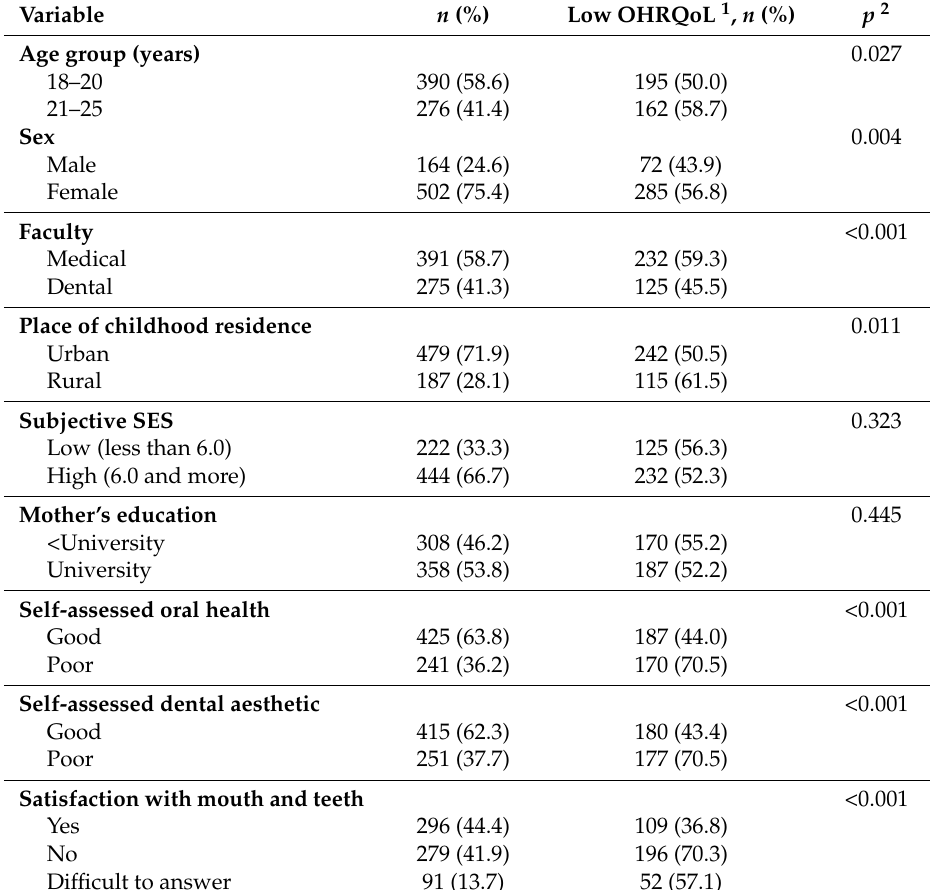
Table 2. Socio-demographic and self-reported oral health characteristics of the study sample and proportion of students with low oral health-related quality of life